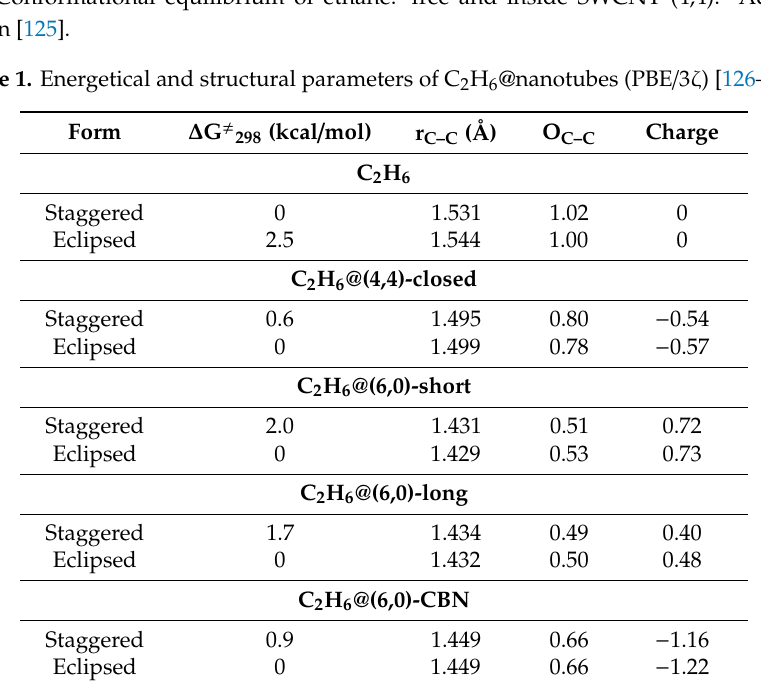
Table 1. Energetical and structural parameters of C 2 H 6 @nanotubes (PBE/3 ζ ) [126–128].